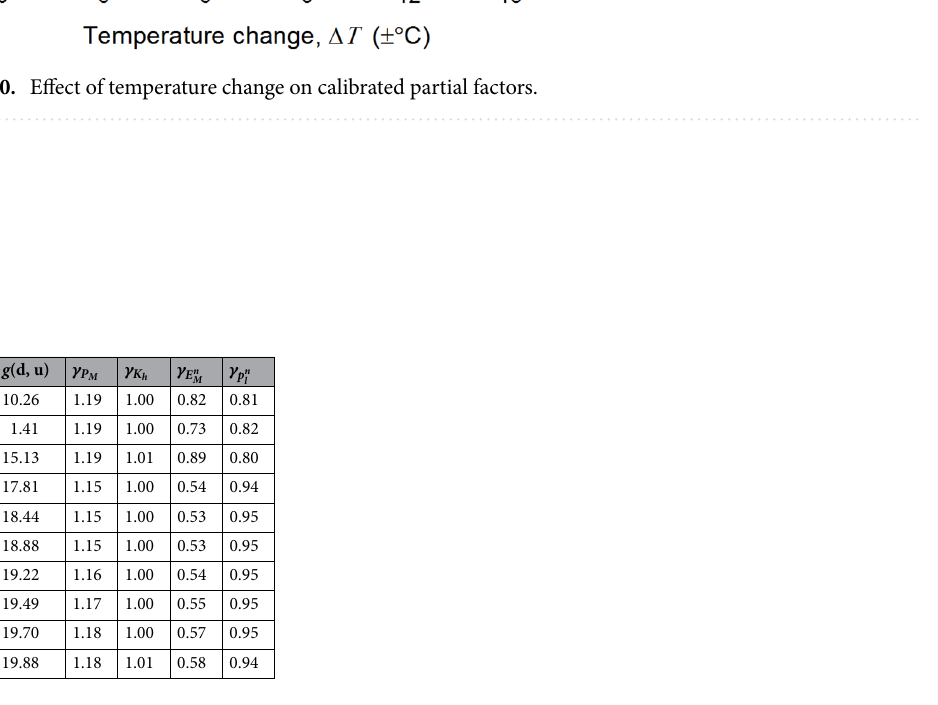
Table 4. Effect of pile length ( L ) on the partial factors calibrated using target reliability method ( D = 0.52